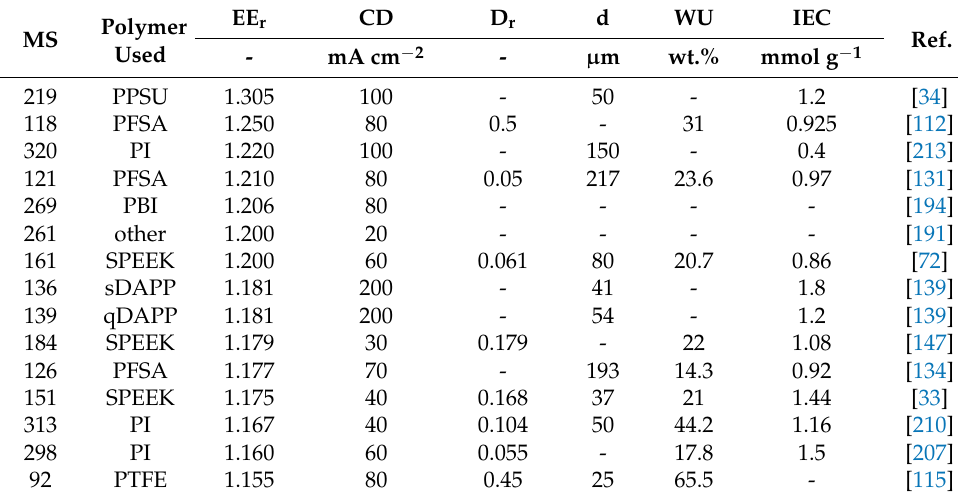
Table 15. High energy efficiency